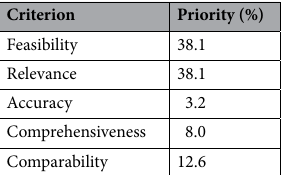
Table 1. Weights of comparison criteria for AHP.